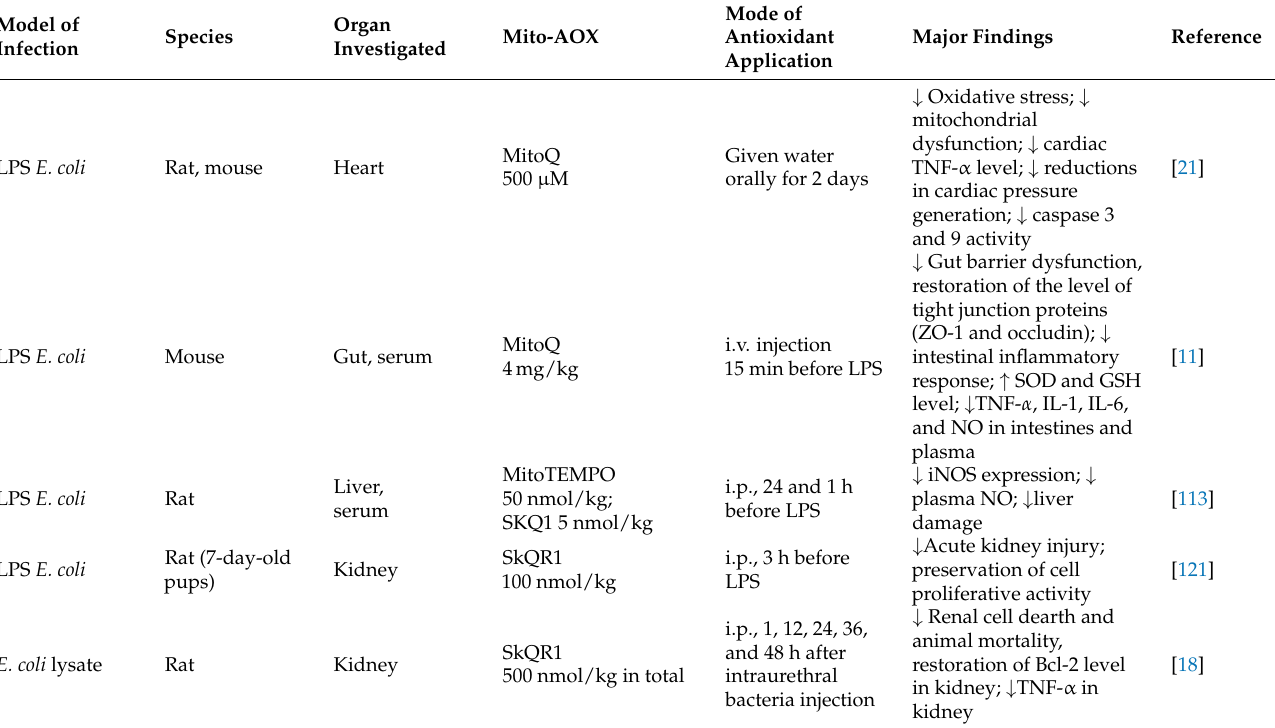
Table 2. In vivo effects of mitochondria-targeted